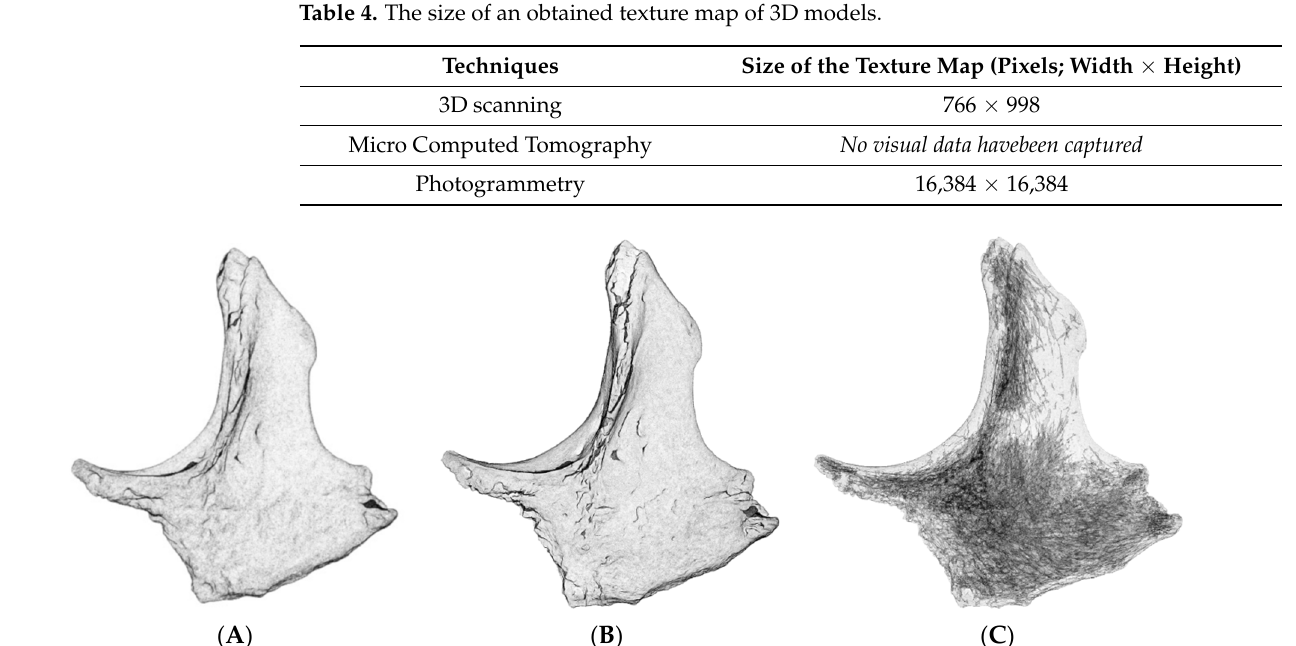
Figure 2. 3D models were created by using different techniques with an X-ray shader applied. ( A ) 3D scanning, ( B ) photogrammetry, ( C ) micro-computed tomography.